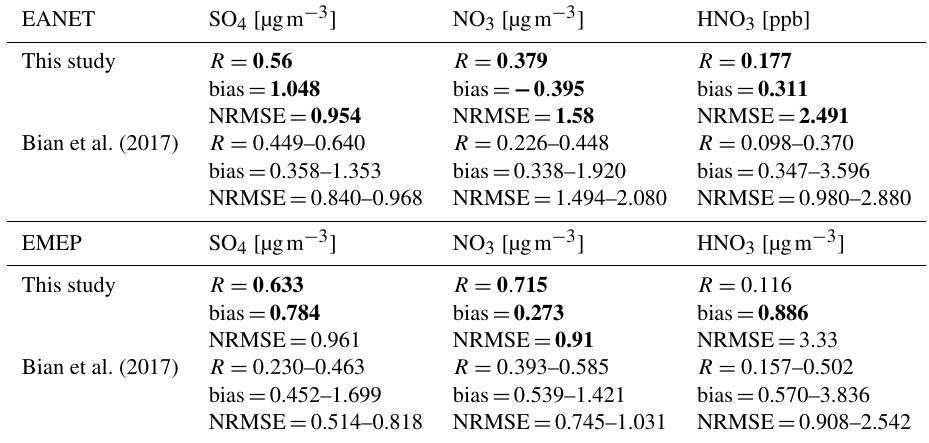
Table 6. Comparisons between EANET and EMEP observations with atmospheric models. Outlier detection follows that in Table 5. The model result is shown in bold if it is better than or agreed with Bian’s report. R has no unit; units in brackets are for biases and